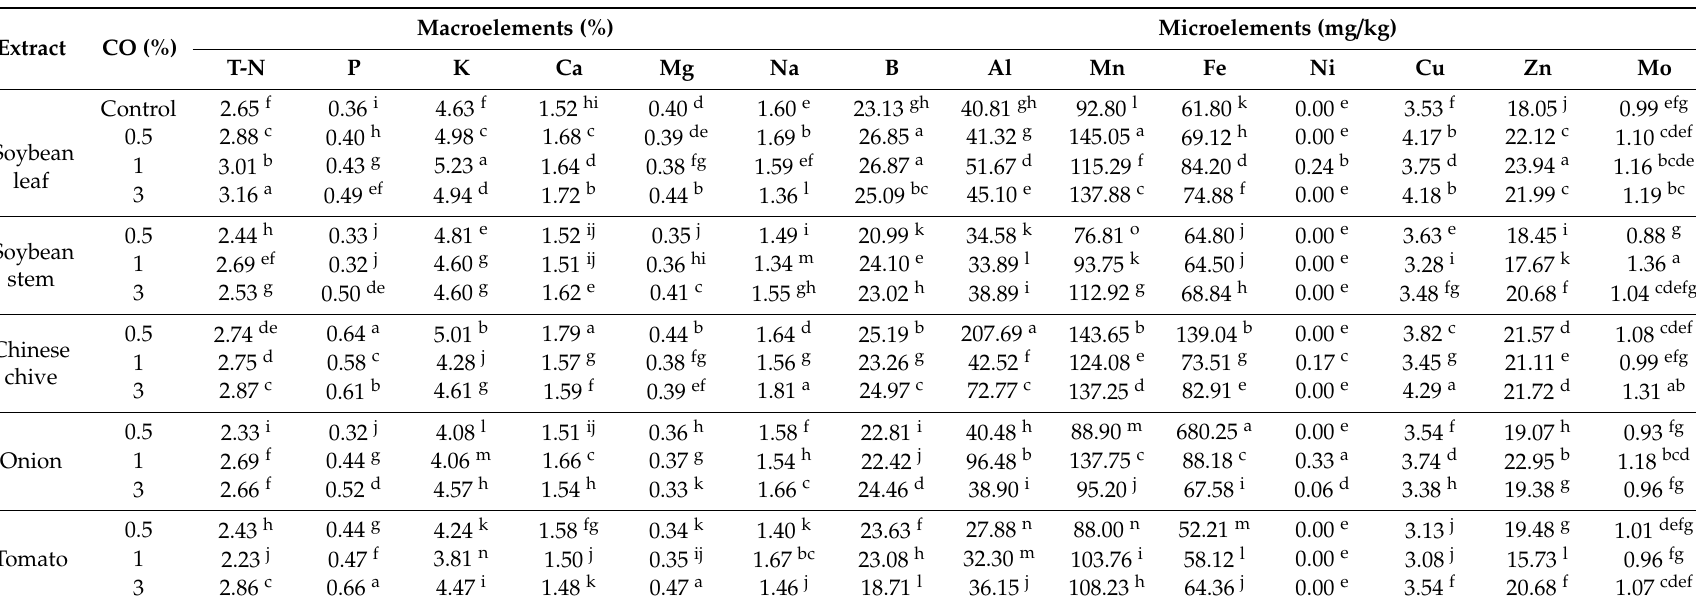
Table 3. Nutrition levels in Peucedanum japonicum leaves treated plant